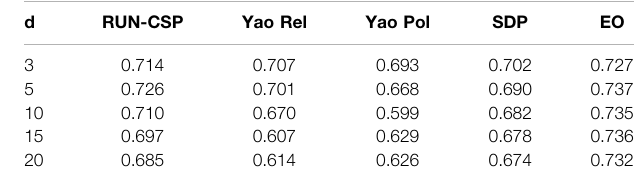
TABLE 1 | M AX -2-SAT: Number of unsatis fi ed constraints for M AX -2-SAT benchmark instances derived from the Ising spin glass problem. Instance